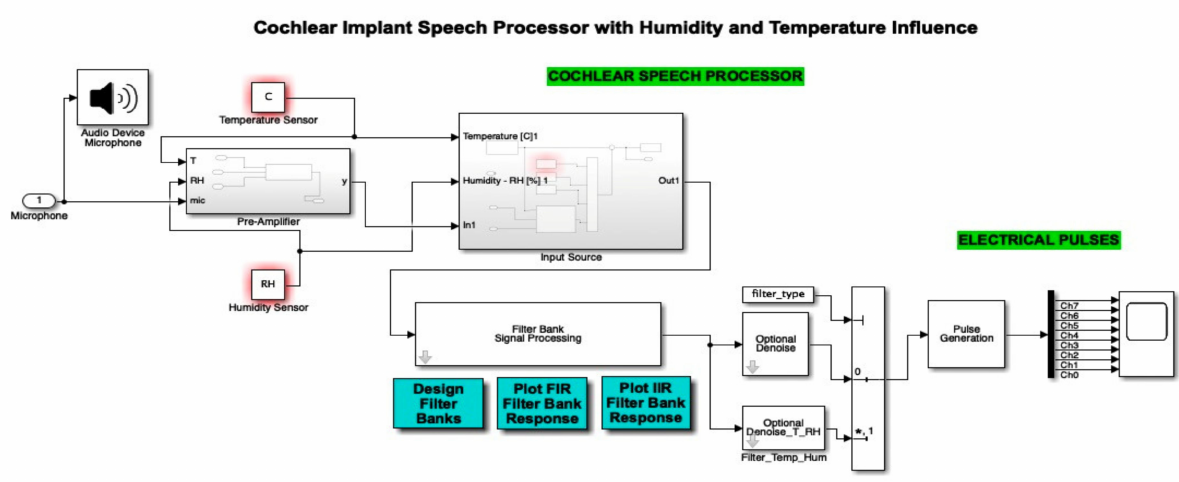
Figure 19. Simulink diagram of the complete simulation featuring the microphone input, the temperature and humidity sensor, as well as the additional filters and denoise blocks. (*: value at the address of variable)Finally, the result of electrical pulse generator for two channels (channel 0 and channel 7) with IIR filter, Gaussian noise, temperature and humidity influence, and the denoise block active is offered in Figure 20, which is plotted for a time interval up to 5 s. All 8 channels have an output in the range ( − 6,6). Similar to Figures 5 and 7, Figures 8 and 9, in Figure 20, out of the eight filter banks available, we chose to present two significant channels, namely the first and last channels (channel 0 and channel